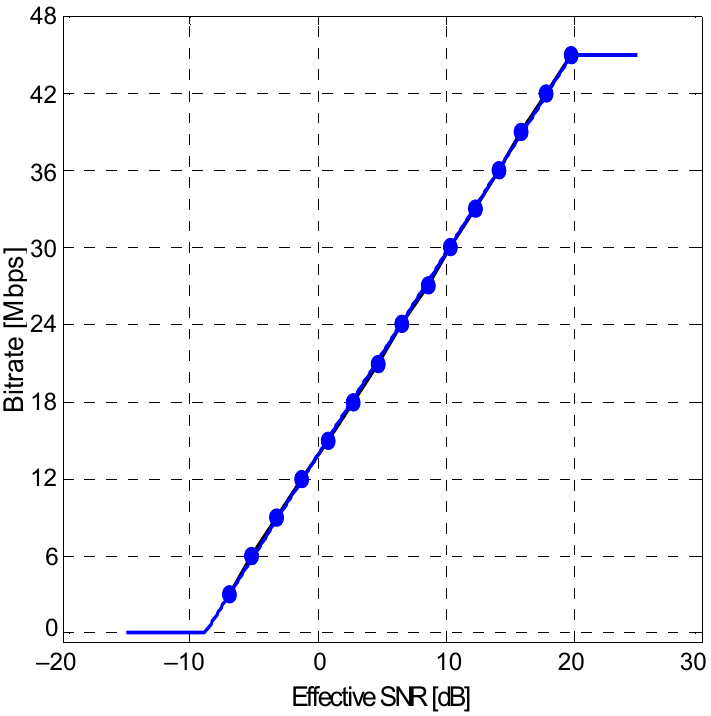
Figure 7. Effective SNR –bitrate mapping. Table 1. Statistical parameters of the considered 4 virtual tunnels.